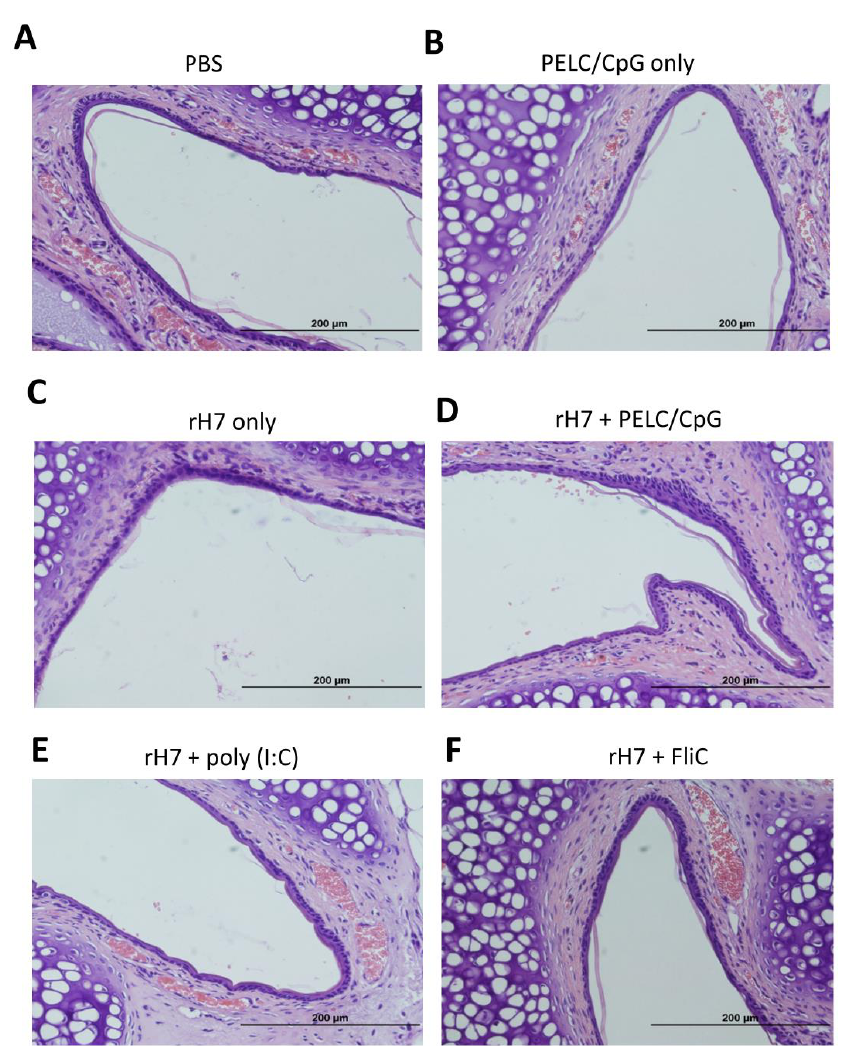
Figure 5. Representative photographs of nasal tissue sections ( × 400 magnification). Groups of mice (N = 3 per group) were intranasally immunized with ( A ) PBS alone, ( B ) PELC / CpG alone, ( C ) rH7 alone, ( D ) rH7 + PELC / CpG, ( E ) rH7 + poly (I:C), or ( F ) rH7 + FliC. One week after the final vaccination, the mice were sacrificed and the nasal tissue sections collected from mice were stained (H&E) for histopathological examination.